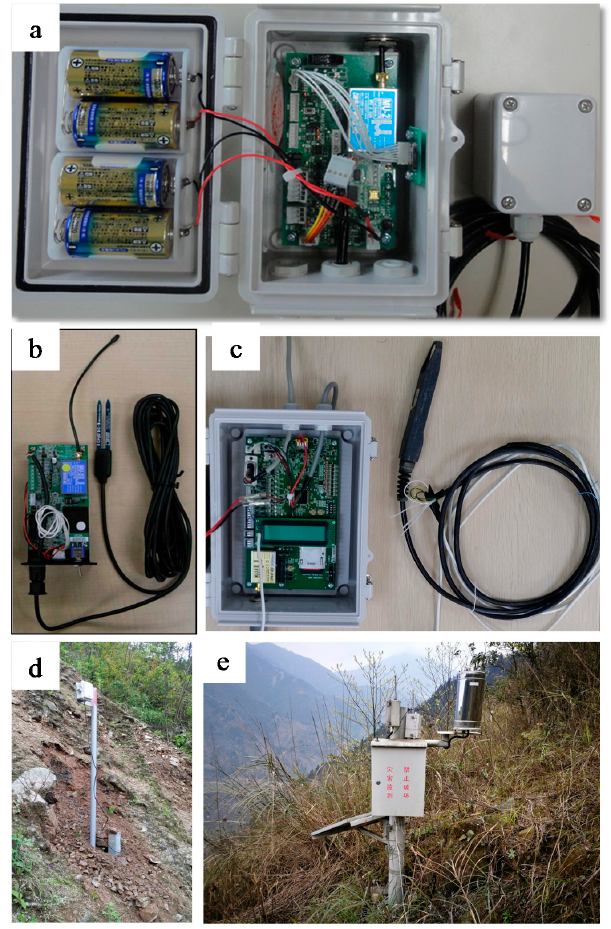
Figure 2. Pictures of instruments proposed for landslide real-time monitoring and early warning system. ( a ) The tilt sensors, ( b ) soil moisture sensors and ( c ) tensiometer integrated with ( d ) sensor unit and installed at the head of the slope in hollow in Yindongzi landslide and ( e ) a tipping bucket rain gauge was connected to the data logger.